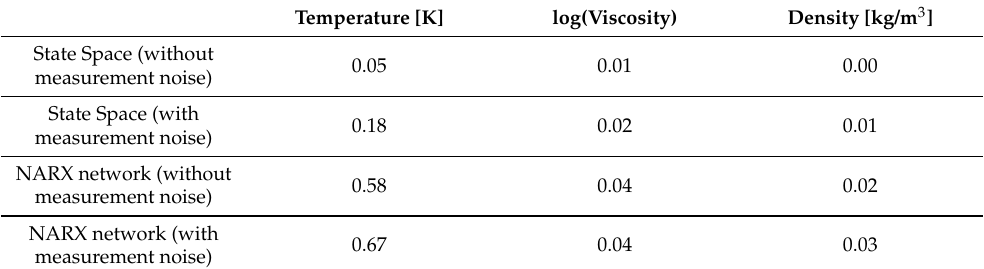
Table 5. Mean NRMSE evaluations between the control and distinctly generated reference trajectories.